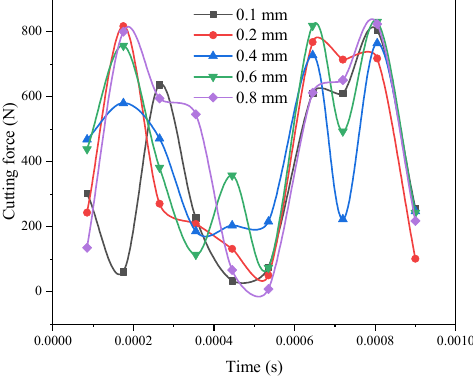
Figure 2. Comparison curve of the maximum cutting force under different corner radii.